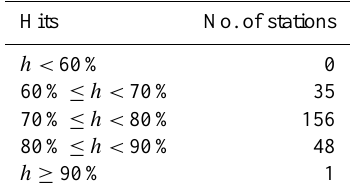
Table 3. Percentage of daily rain occurrence hits of the RACMO2 model from 1990 to 2009 at 240 European observational